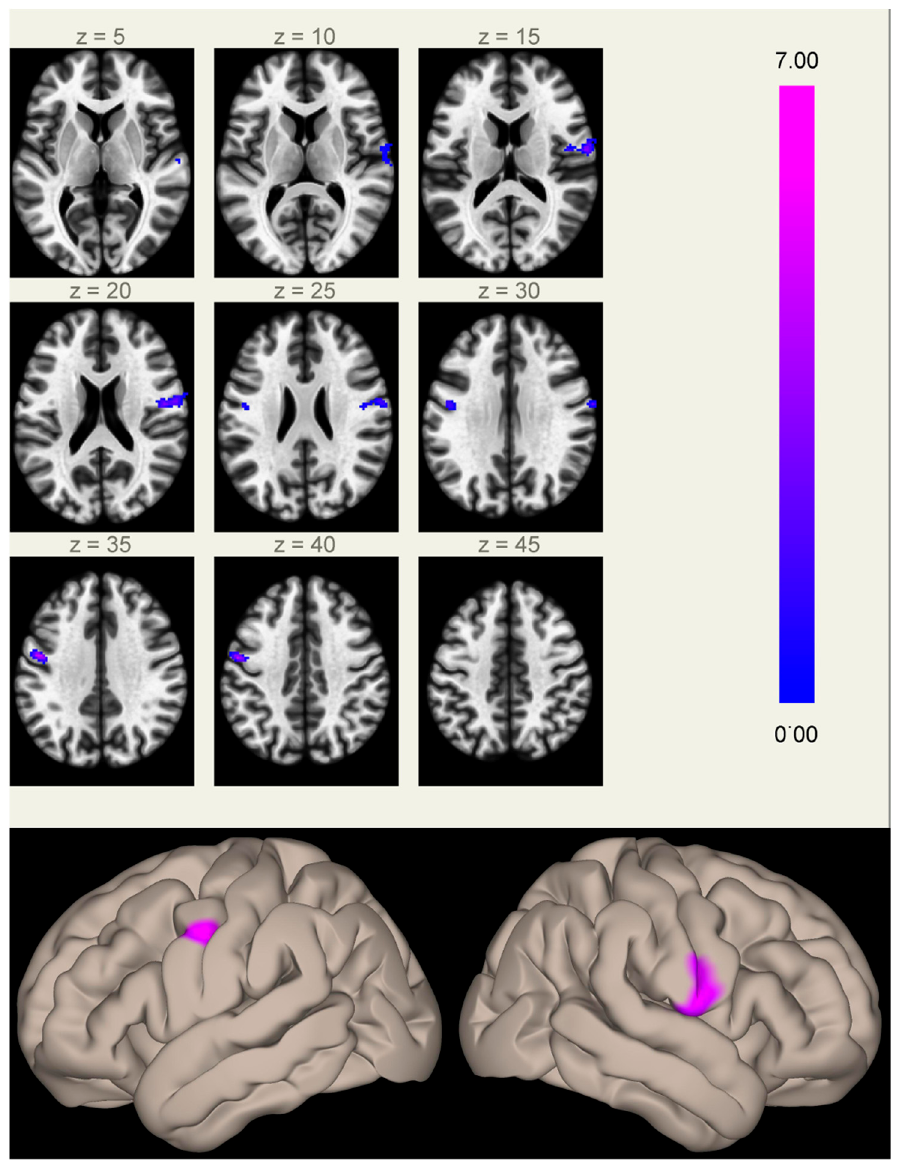
Figure 1. Clusters of increased correlation with the MPFC (anterior hub of the default mode network) in Group A compared to Group B. Significant clusters are located in the inferior part of the right (2.8 cm 3 , MNI coordinates of cluster maximum [+60 − 06 +16]) and left (1.4 cm 3 , [ − 48 − 04 +34]) precentral gyri. The color scale represents T -values from the GLM. Table 4. Results of the WCST scale in the patients of the study.